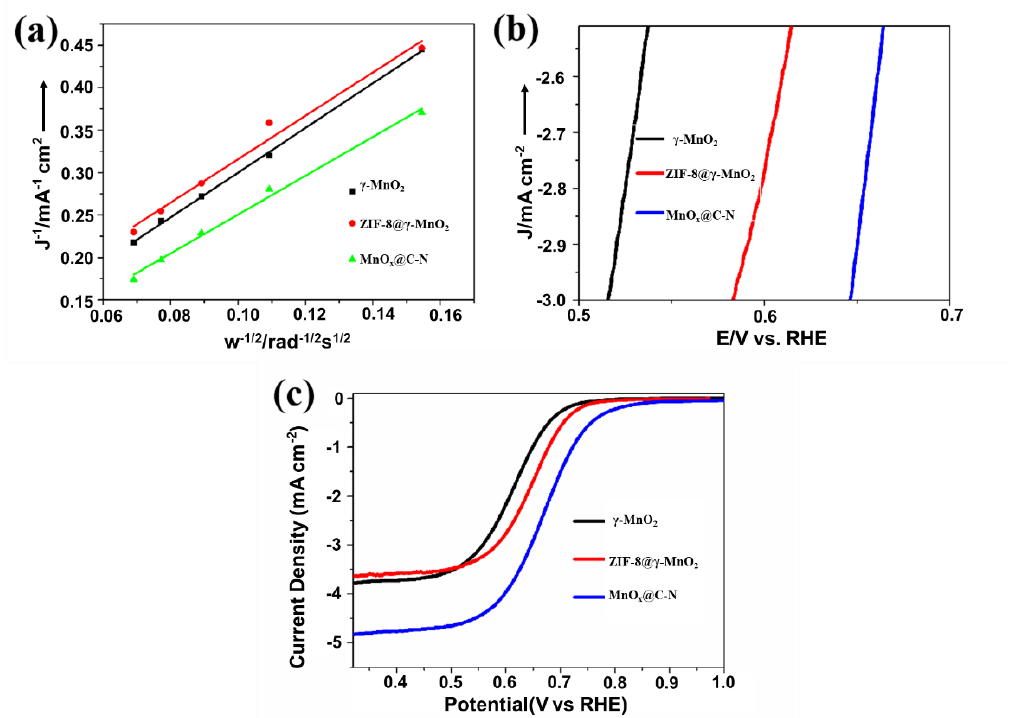
Figure 8. ( a ) K–L plot at 0.45 V; ( b ) Specific activities of the samples near the half-wave potential region at a rotation speed of 1200 rpm; and ( c ) LSV curves of γ -MnO 2 , ZIF- 8@γ -MnO 2, and MnO x @C-N at 1200 rpm.